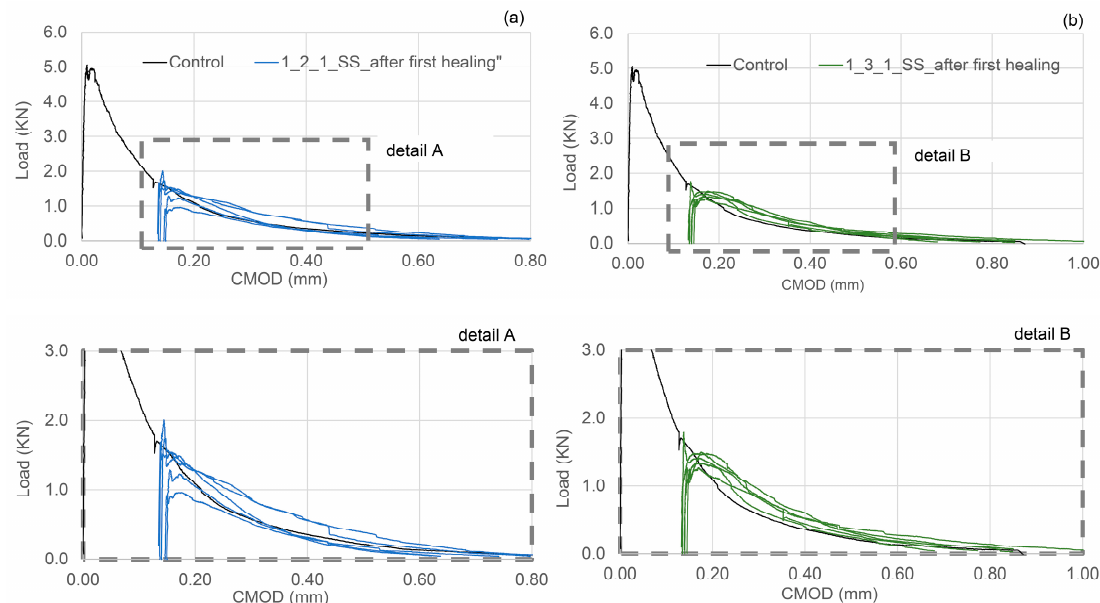
Table 3. Group 1: Flexural test results and indices of healing for one damage-healing cycle.